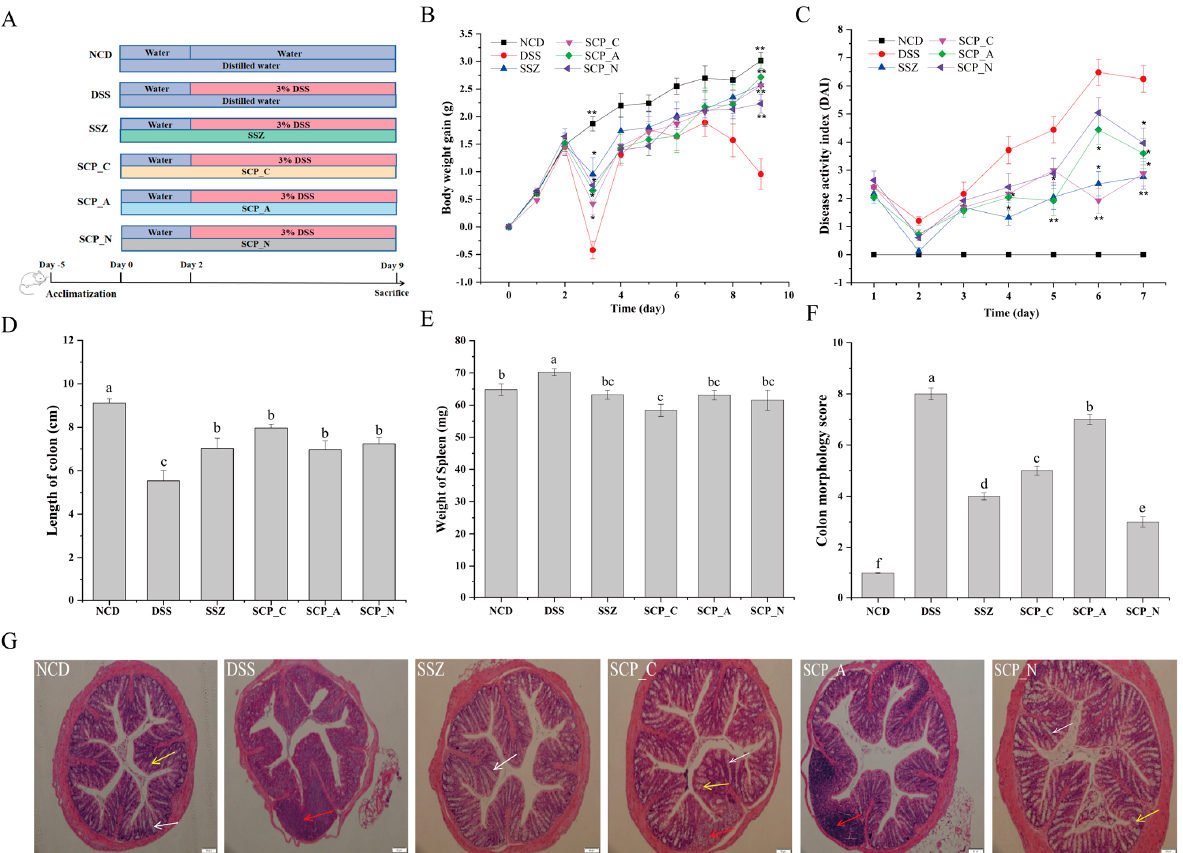
Figure 2. Polysaccharide alleviated symptoms of DSS-induced UC in mice. ( A ) Experimental design; ( B ) Body weight gain; ( C ) DAI scores; * p < 0.05, ** p < 0.01 vs. DSS. ( D ) Colon length; ( E ) Spleen weight; ( F ) Colon morphology score; ( G ) H & E staining microscopic image of colon tissue. The red, yellow, and white arrows indicate the locations of inflammatory infiltration, goblet cells, and crypts, respectively (scale bars 100 µ m). Different letters (a–f) represent significant differences among groups ( p <